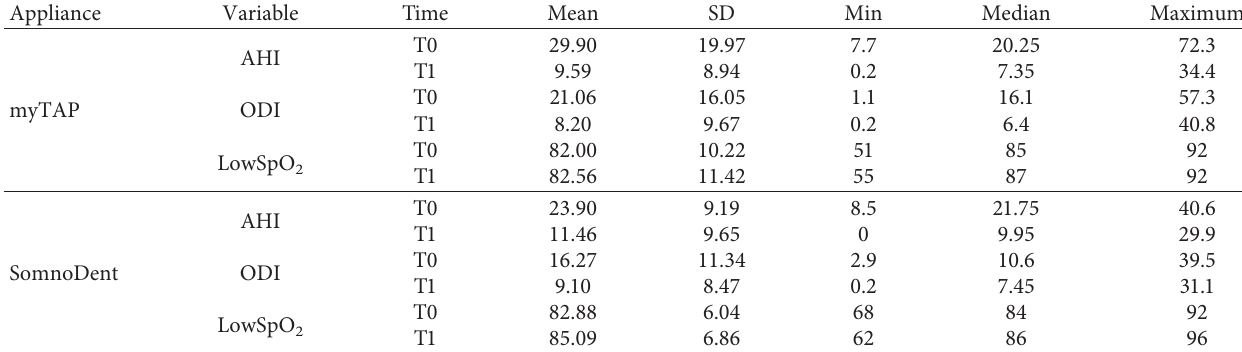
Table 2: Short-term effects of the appliances on respiratory variables.